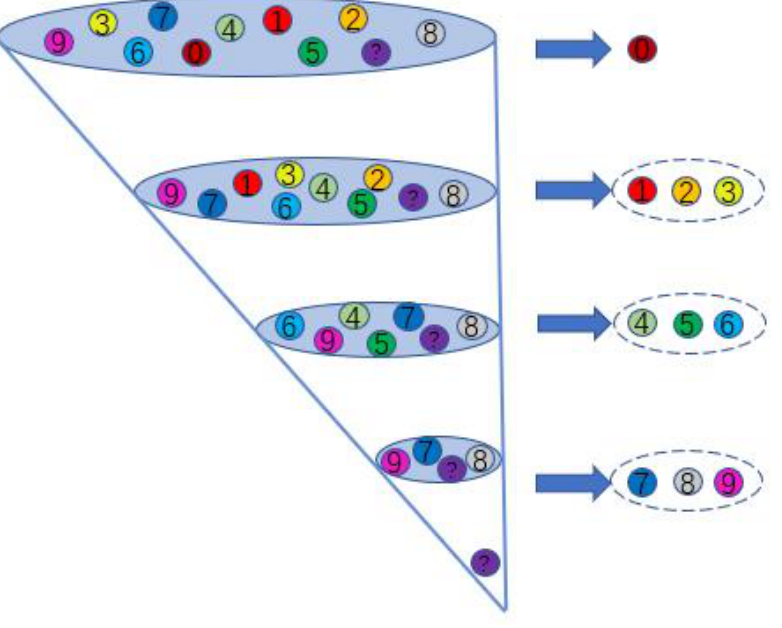
Figure 9. Graphical diagram of the diagnosis process.